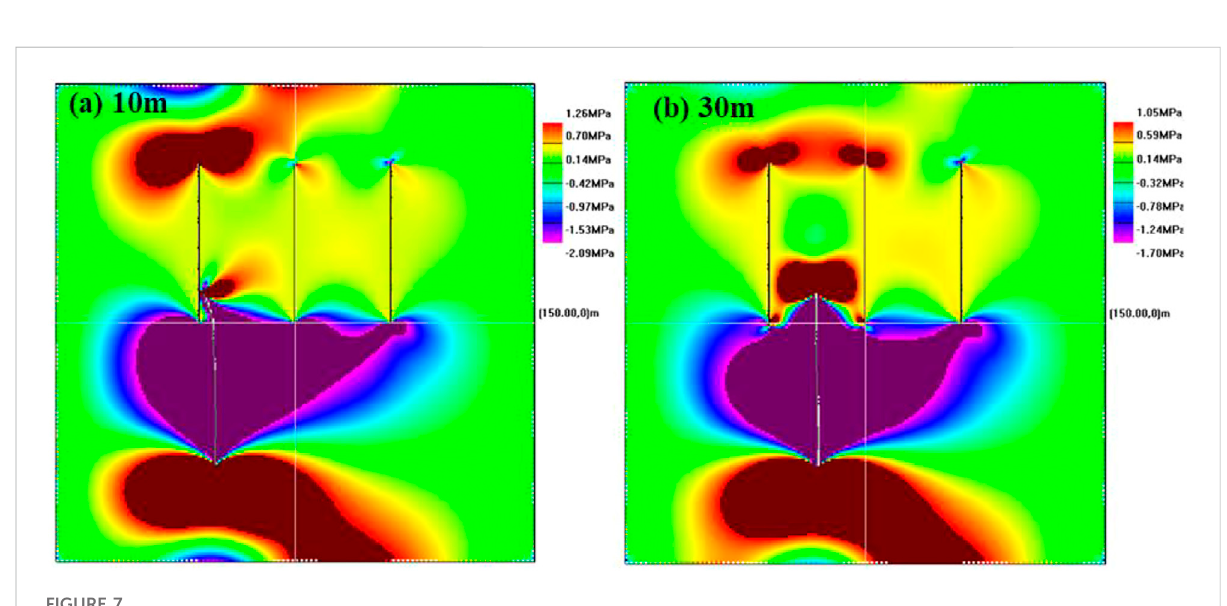
FIGURE 7 Normal stress fi eld distribution in X-axis direction of single arti fi cial fracture